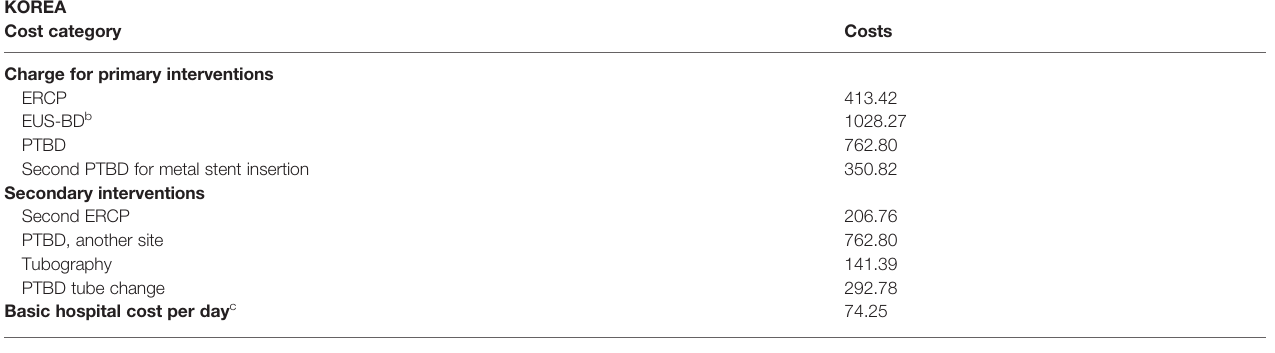
TABLE 1 | Overview of cost calculations for interventions in US dollars a